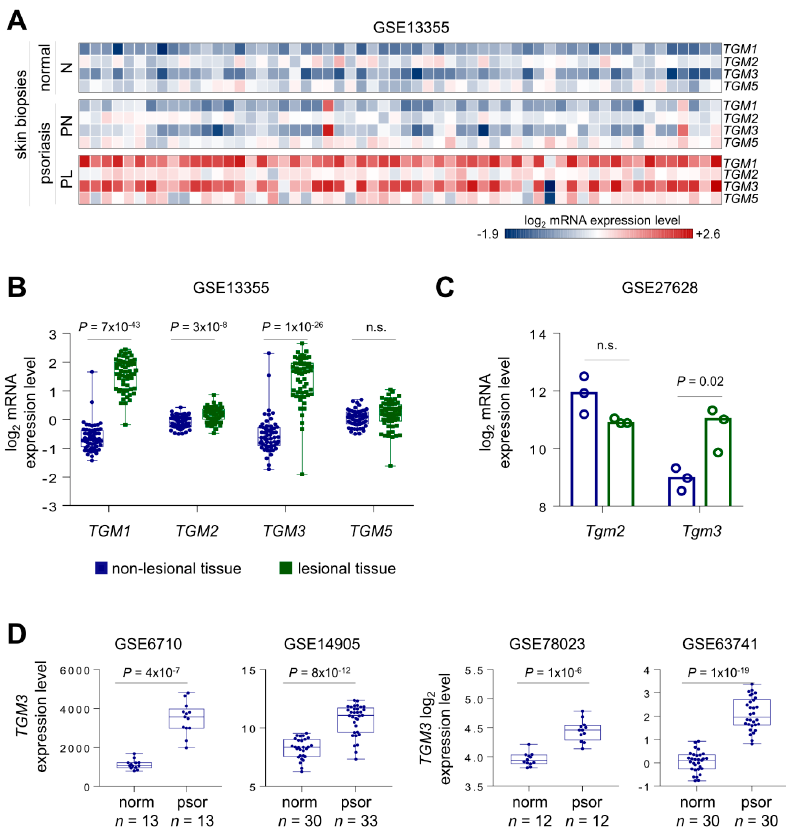
Figure 1. TGM1 and TGM3 are upregulated in skin samples from psoriasis patients. (A) Heat map showing